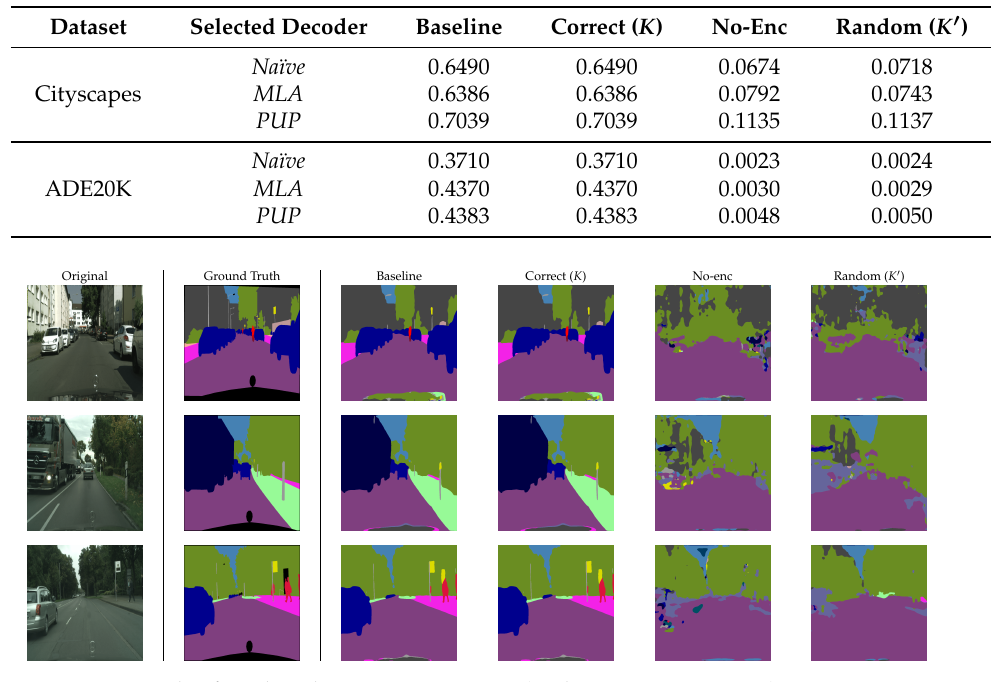
Figure 5. Example of predicted segmentation maps (with PUP on Cityscapes).